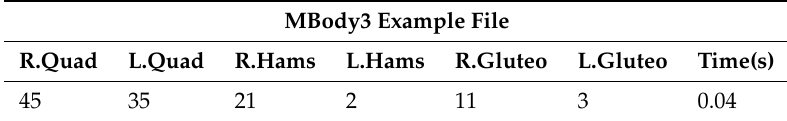
Table 3. Example of Mbody3 CSV